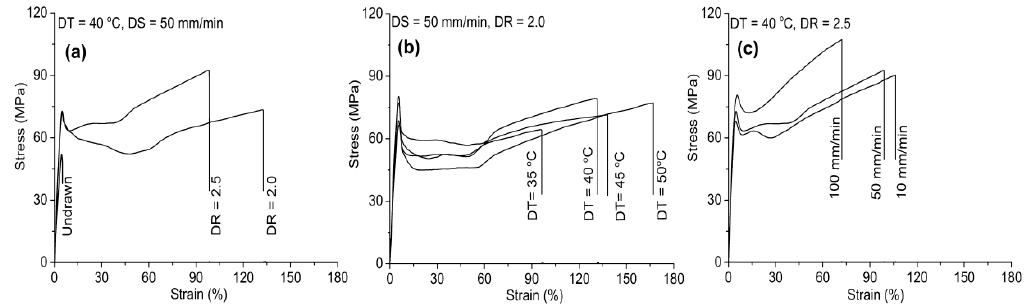
Figure 8. Typical stress-strain curves of the nanocomposite tapes: ( a ) different drawing ratio (DR) drawn at 40 °C with drawing speed (DS) of 50 mm/min; ( b ) DR 2.0 drawn at different temperatures with DS of 50 mm/min; and ( c ) DR 2.5 drawn at 40 °C with different speeds. Reprinted with permission from [88].